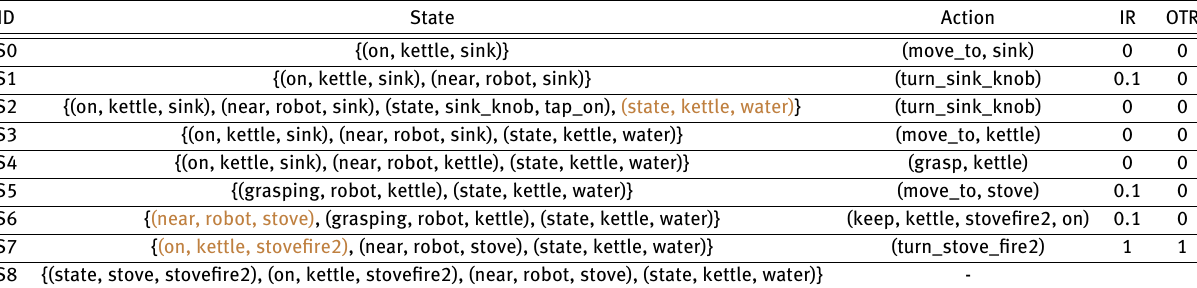
Table 1: The reward function for the optimal sequence of the boiling water objective. The environment with only-terminal reward (OTR) does not provide any reward until the terminal state. However, the agent with the intermediate reward receives a small reward whenever the agent achieves predicates from the terminal state